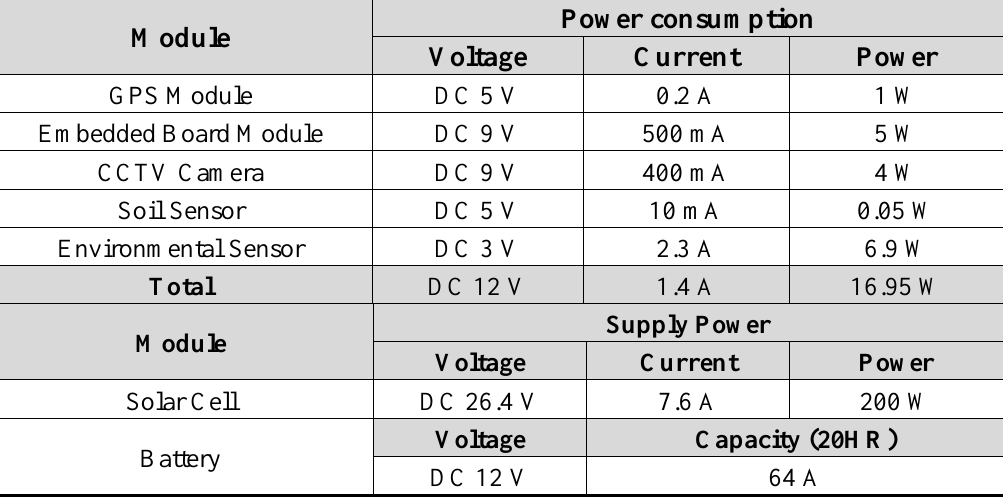
Table 5. Power Consumption of Module and Power Supply of Solar Battery.